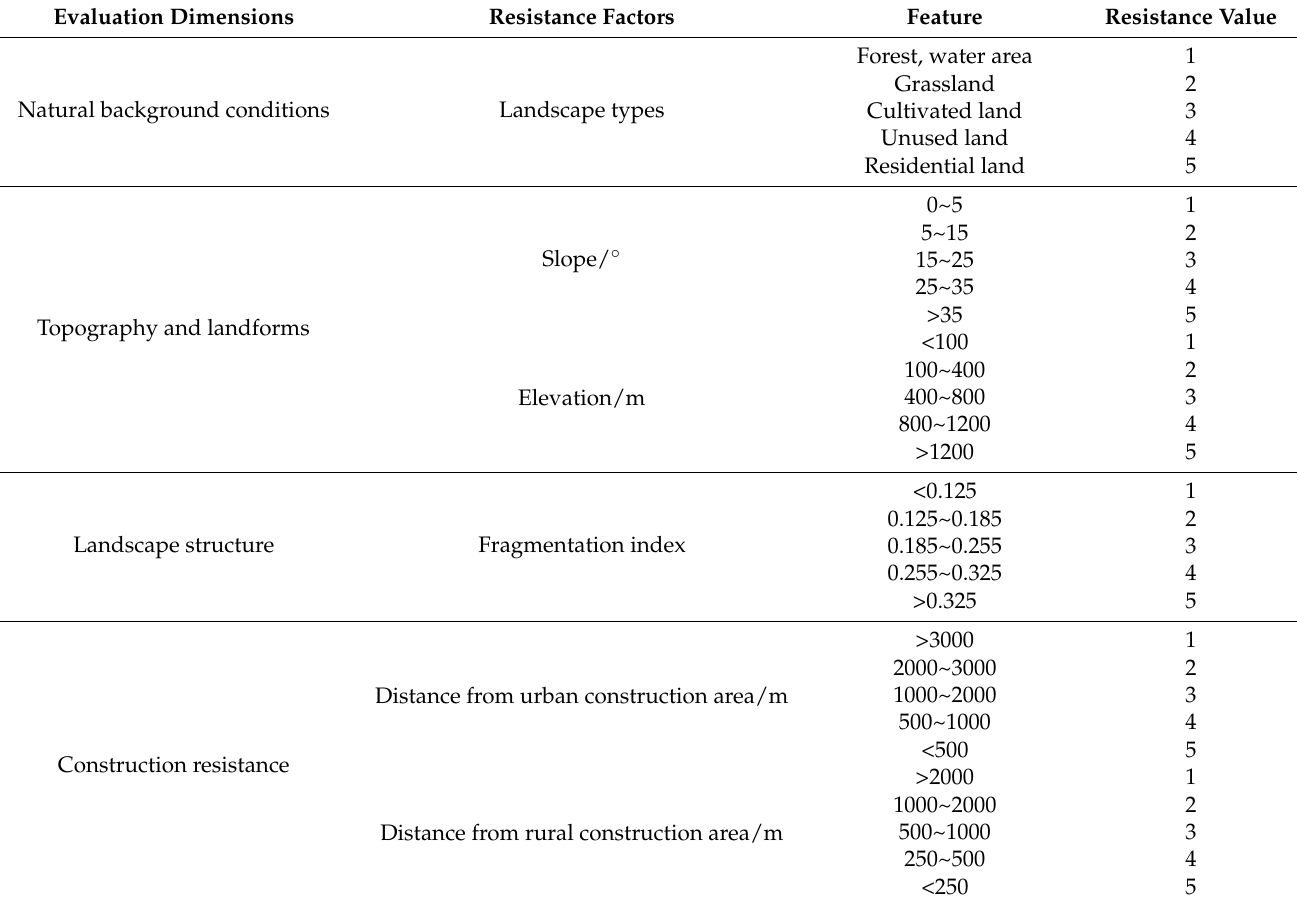
Table 3. Criteria used to calculate resistance